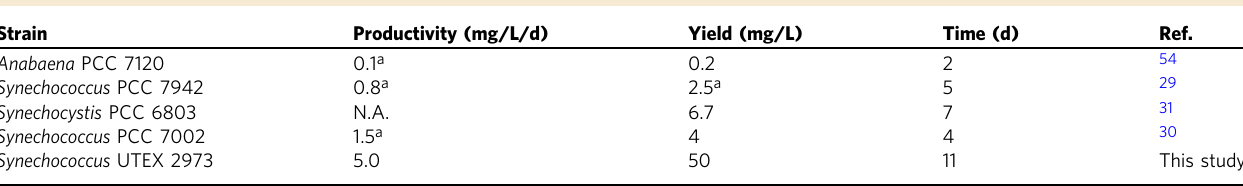
Fig. 5 Sustainable and higher limonene and biomass productivities achieved in SAC. a Concept fi gure shows the integration of machine learning- informed SAC and ABS for biofuel production. By overcoming light limitation, SAC (SC) shows sustainable limonene and biomass production, maintaining productivities at around 5 mg/L/day and about 2.2 g/L/day for limonene and biomass, respectively (SC, b , c ). By contrast, both limonene and biomass production in batch cultivation (BA) reach plateau at day 2 due to nutrient depletion (BA, b , c ). With fed-batch, limonene, and biomass production are enhanced but eventually fl attened due to light limitation (FB, b , c ). The growth of cyanobacteria with batch (BA), fed-batch (FB), and SAC (SC) are shown in d . Data are presented as mean values ±standard deviations ( n = 3 independent samples). Source data are provided as a Source Data fi le. Table 1 Recent publications about limonene production in cyanobacteria.